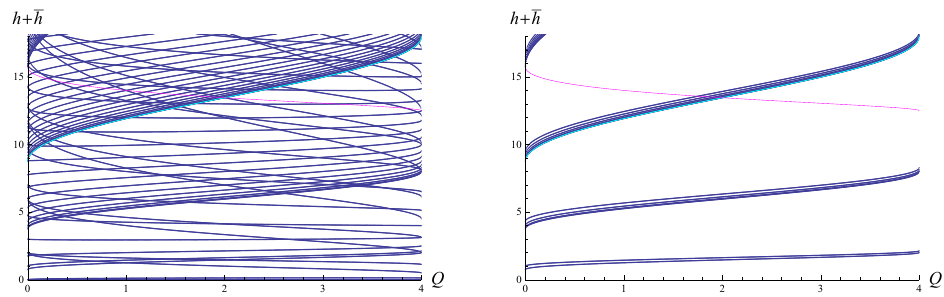
Figure 27 . The truncation of the Potts spectrum (2.20) in the interchiral bootstrap. On the left we plot the total dimensions h + ¯ h for the primary fields in the spectrum. After organizing them in terms of ATL modules, we plot on the right the total dimension of the leading fields in the ATL modules whose amplitudes are taken as the overall amplitude A ( W ) in the interchiral conformal block expansions of the geometrical correlations and need to be determined by the bootstrap. We truncate at j = 6 and plotted the total dimension of ( r, s ) = (0 , 6) in cyan. However we include the diagonal null descendant ( r, s ) D = (3 , − 2) whose dimension is plotted in magenta. Notice that its total dimension is larger than the truncation for 0 ≤ Q < 2 .